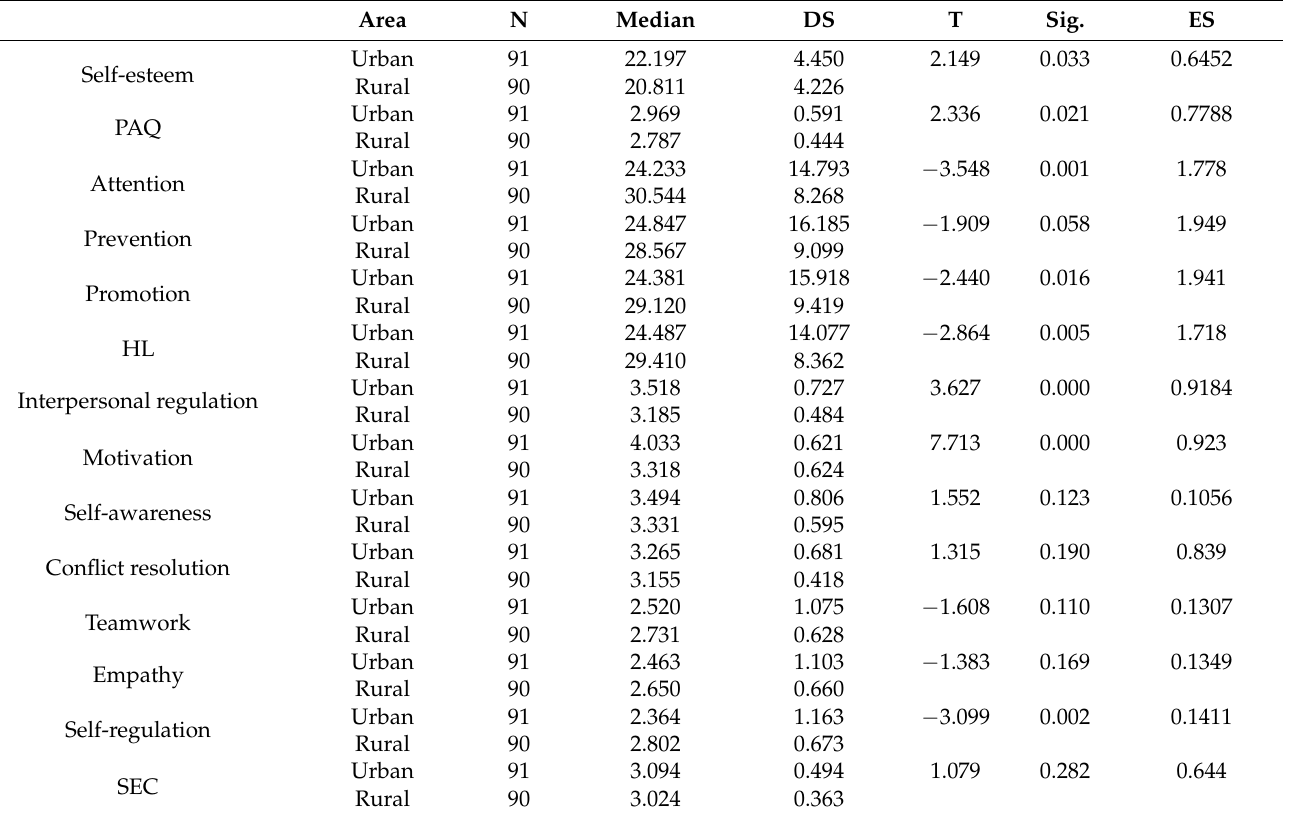
Table 3. Disparities in the amount of physical activity, health literacy, socioemotional competencies, and self-esteem between urban and rural areas. Area N DS